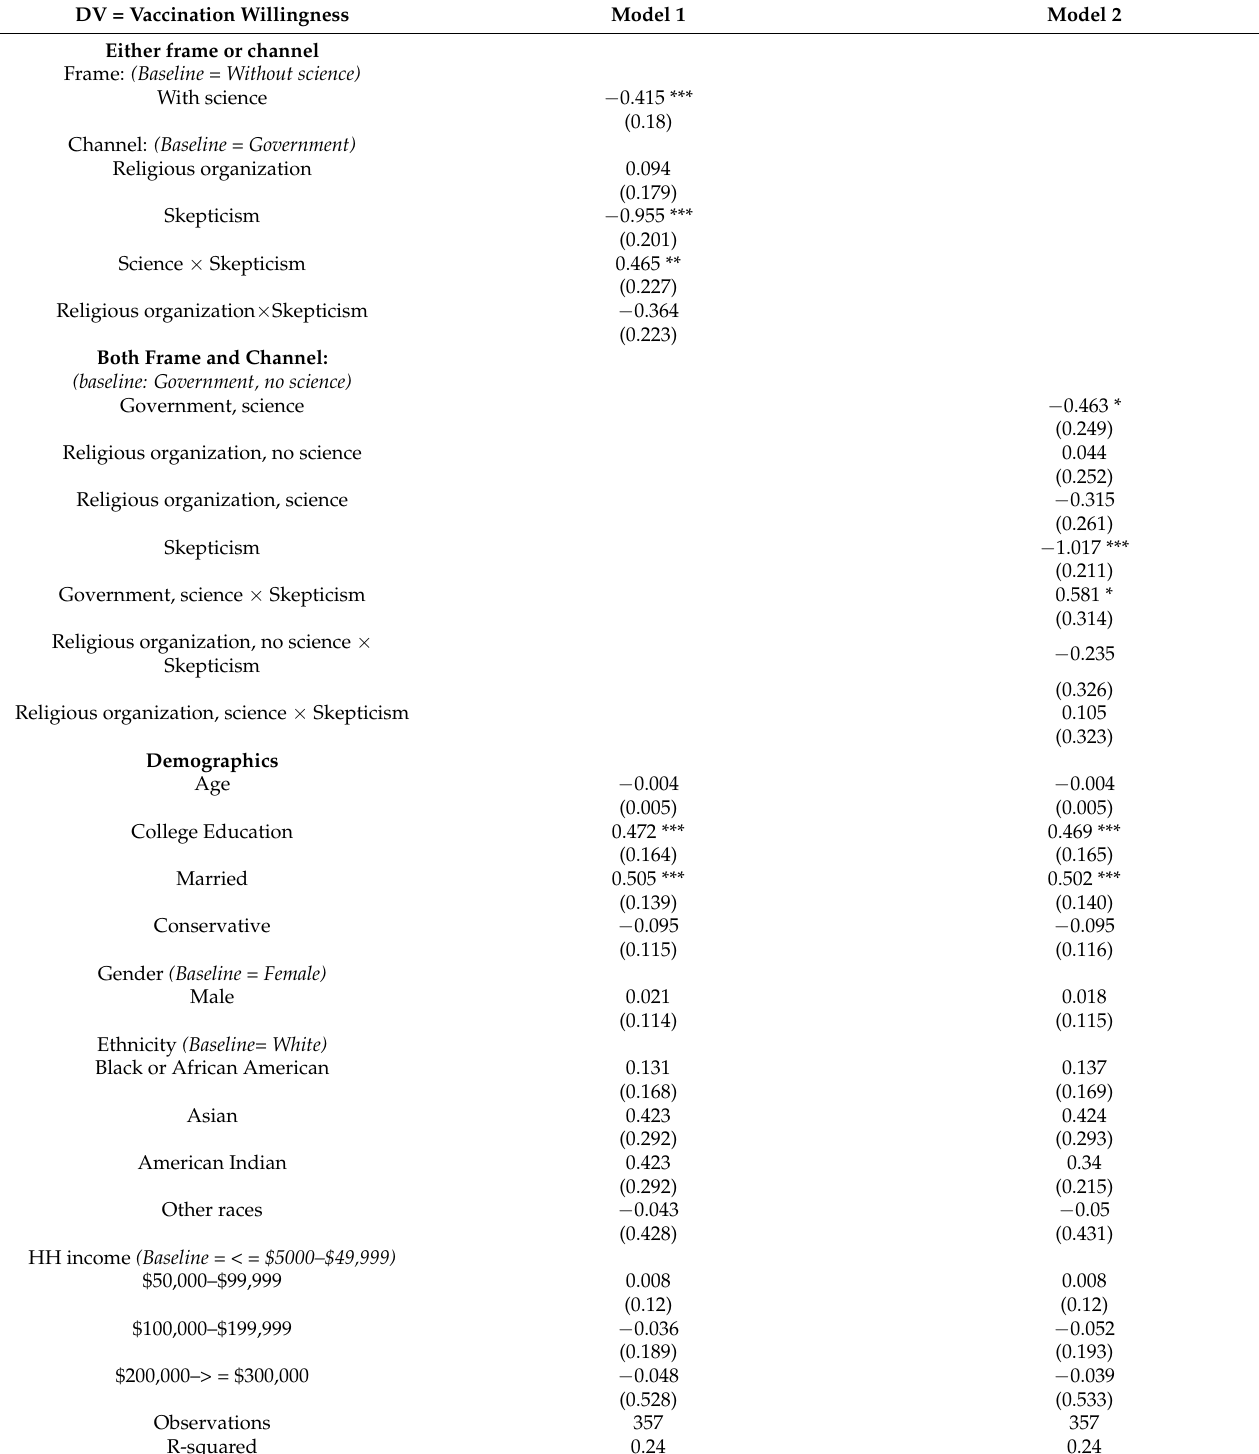
Table A3. Vaccine information frame, channel, and vaccination